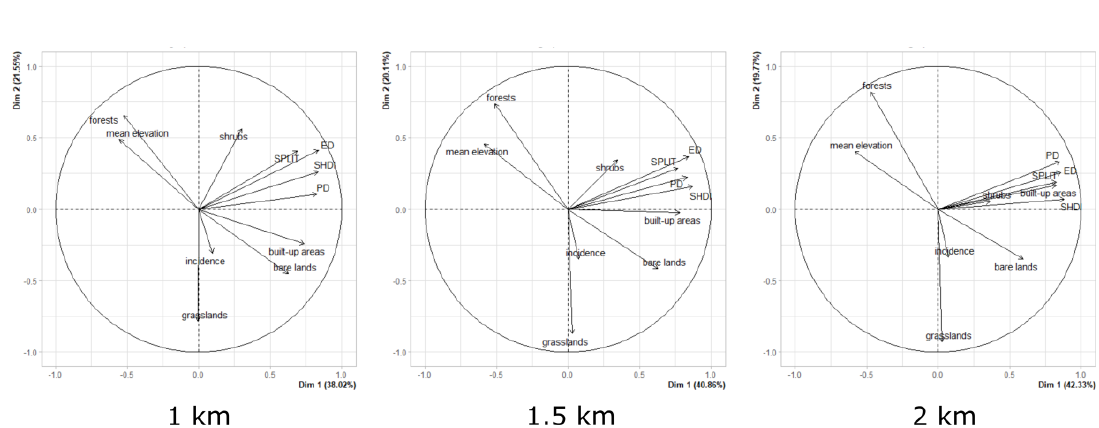
Figure 7. Correlation plot of the PCA analyses with the three bu ff er sizes in Grande